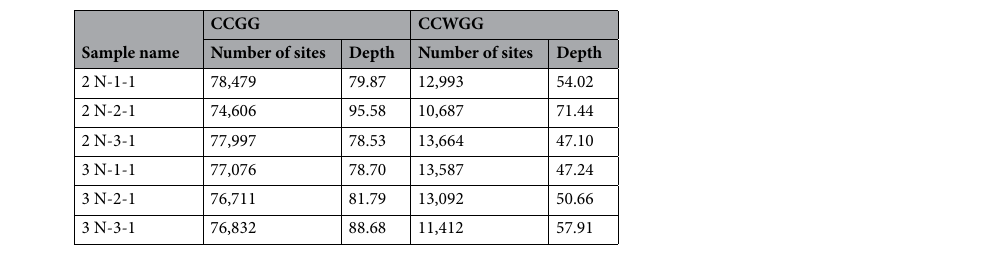
Table 1. Coverage depth of methylation